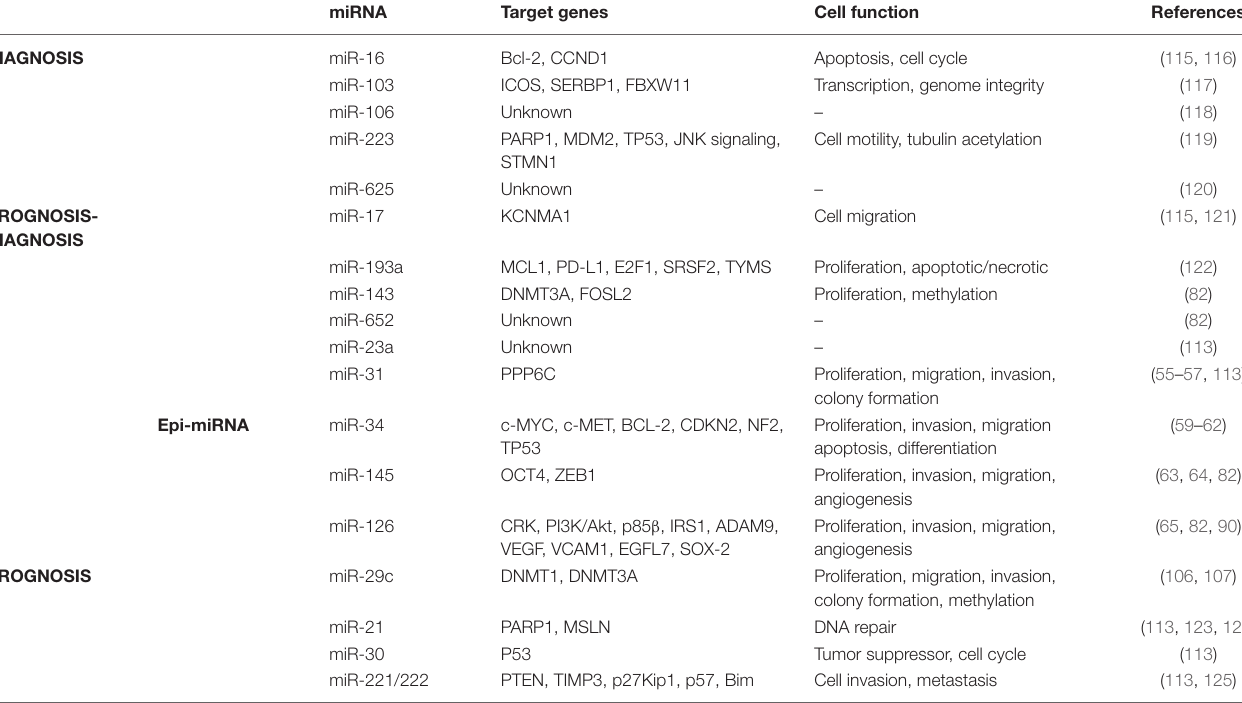
TABLE 1 | MiRNAs with diagnostic and prognostic value and their targets in malignant mesothelioma.